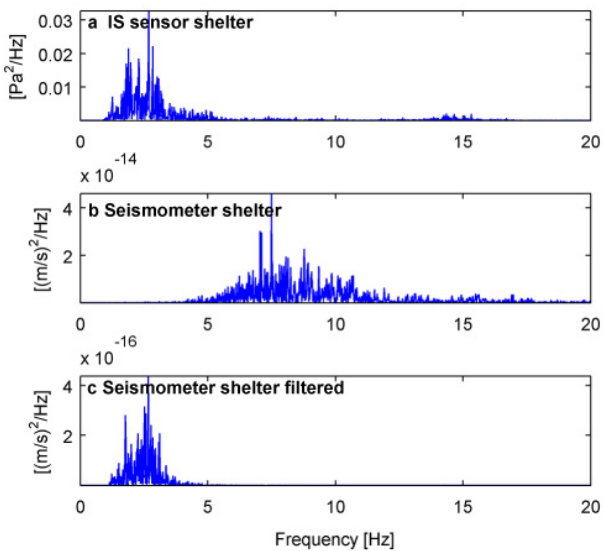
Fig. 7. Total spectra for the time interval [500s to 620s] of Avalanche 1 (Fig. 6). (a) Infrasound time signal from the sensor near the shelter; (b) N-S component Seismogram near the shelter; and (c) N-S component filtered (1–3Hz) Seismogram near the shel- ter. Note the different scale of amplitudes (10 − 16